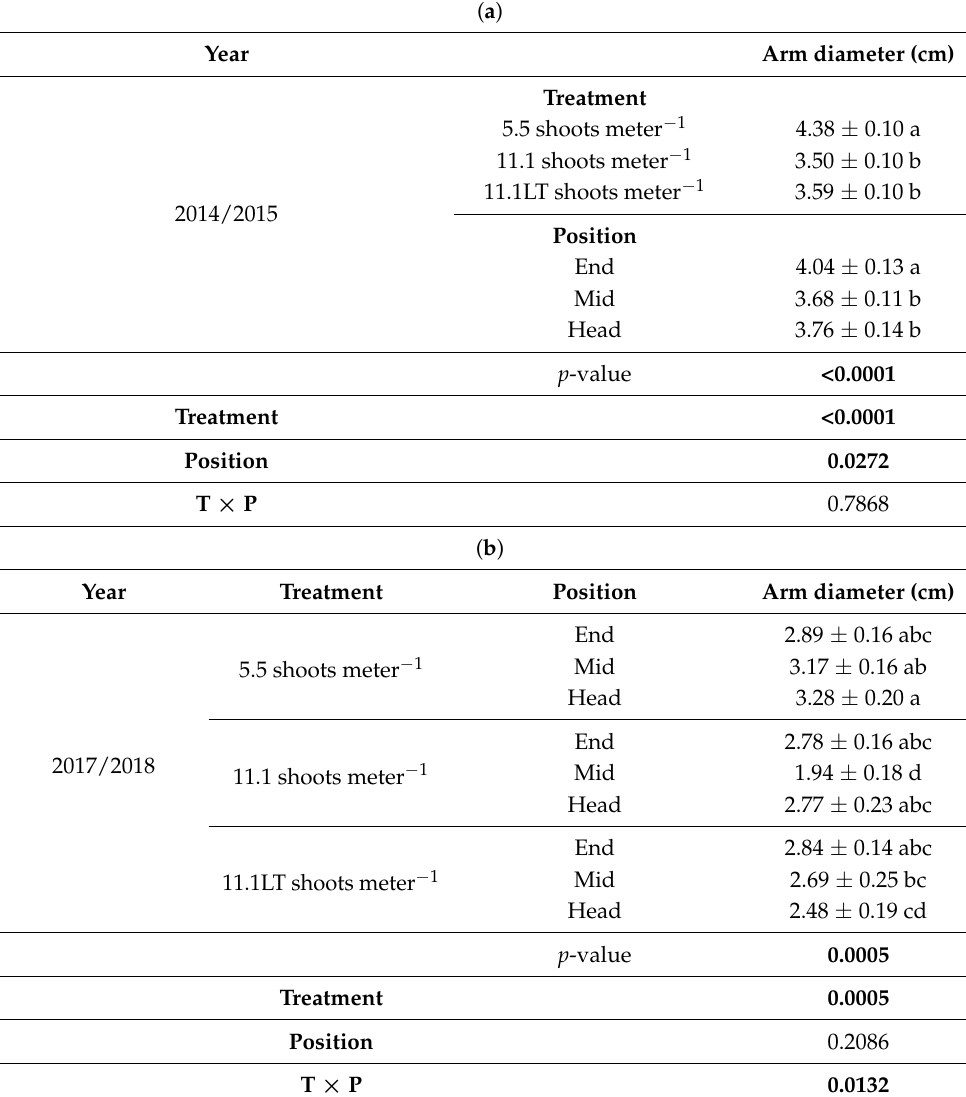
Table 3. Two-way analysis of variance (ANOVA) with interaction showing average arm diameter (cm) by year, treatment, and cordon position at the conclusion of winter pruning 2015/2016 ( a ) and at the conclusion of the experiment in 2017/2018 ( b ) ( n = 8). Table shows treatment and position means followed by the standard error of the mean. Different letters within a column indicate significant differences based on an Each pair, Student’s t -test. Significant p -values (<0.05) are displayed in